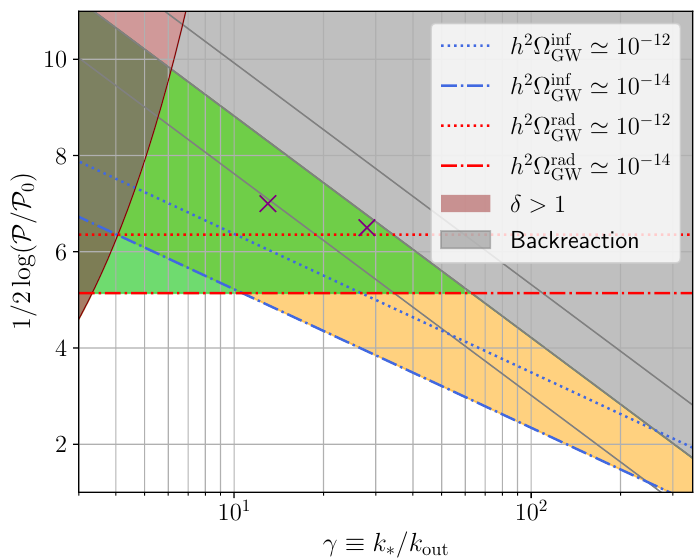
Figure 9 . Backreaction constraints versus amplitudes of Ω GW . The colour code is the same as in figure 7. Different grey lines correspond now to the bound in eq. (5.5). For given ( γ, p ) , a change in the slow-roll parameter (here fixed to (cid:15) = 0 . 01 ) would mildly influence the position of the backreaction constraints — see text.